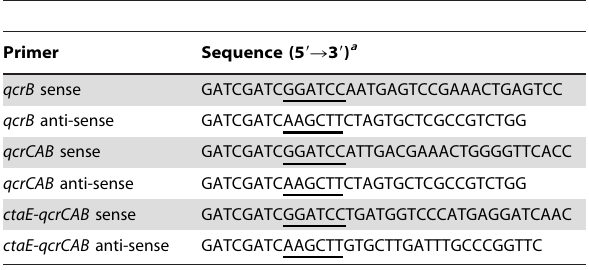
Table 2. Primers used for the construction of pMV261:: qcrB ,